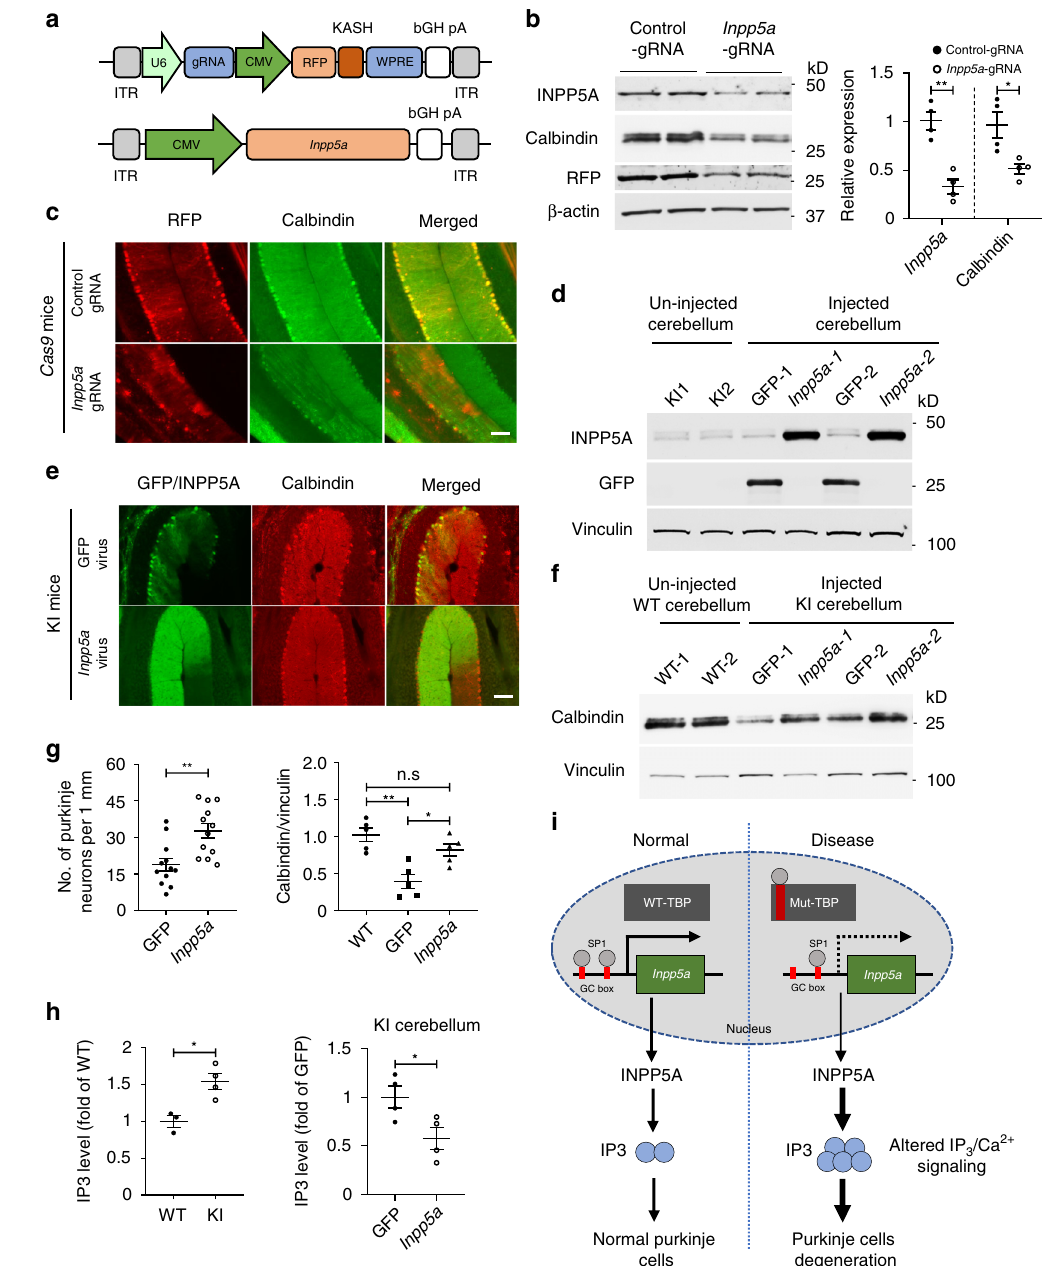
Fig. 6 Inpp5a Knockdown leads to Purkinje cell degeneration, whereas Inpp5a overexpression reduces Purkinje cell degeneration. a Schematic diagram of AAV- Inpp5a gRNA and AAV- Inpp5a vectors. b Western blotting analysis of INPP5A and calbindin in AAV-control gRNA or AAV- Inpp5a gRNA-injected 3-month-old EIIa- Cas9 transgenic mice cerebellum (left panel). The densitometric ratios of INPP5A to β -actin and calbindin to β -actin were normalized to control and analyzed with Student ’ s t test (right panel). Calbindin, t = 3.095, * P = 0.0213; Inpp5a , t = 5.79, ** P = 0.0012, n = 4 mice per group. c Representative immuno fl uorescence images of AAV-gRNA-injected Cas9 mouse cerebellum without mutant TBP. d Western blotting showing the expression of AAV- Inpp5a or AAV-GFP in the injected KI mouse cerebellum. e Representative immuno fl uorescence images of AAV- Inpp5a or AAV-GFP- injected 5-month-old KI mouse cerebellum. f Western blotting showing increased calbindin in the cerebellum of SCA17 mice after injection of AAV- Inpp5a . AAV-GFP injection served as control. g Quanti fi cation of Purkinje cells (left panel) in e was analyzed with Student ’ s t test, t = 3.483, * P = 0.0011, n = 4 mice per group, three images were used to count from each mouse. The densitometric ratios of calbindin to vinculin in f were normalized to WT and analyzed with one-way ANOVA followed with Tukey ’ s multiple comparisons test. F = 12.32, * P < 0.05, ** P < 0.005. n = 5 mice per group. h IP 3 ELISA assay of cerebellar lysates from 2-month-old KI mice and age-matched WT mice (left) and from AAV- Inpp5a or AAV-GFP-injected 3-month-old KI mice (right). IP 3 levels (fold of WT or fold of GFP) were analyzed with Student ’ s t test, t = 3.77, * P = 0.013 (left); t = 2.681, * P = 0.0365 (right), n = 3 – 4 mice per group. i A proposed model for selective neurodegeneration in SCA17. Mutant TBP downregulates INPP5A by inhibiting SP1 from activating Inpp5a transcription. The reduction of INPP5A dysregulates the IP 3 /Ca 2 + pathway, leading to Purkinje cell degeneration. Scale bar = 100 μ m. Data are represented as mean ± SEM. Source data and full blots are provided as a Source Data fi